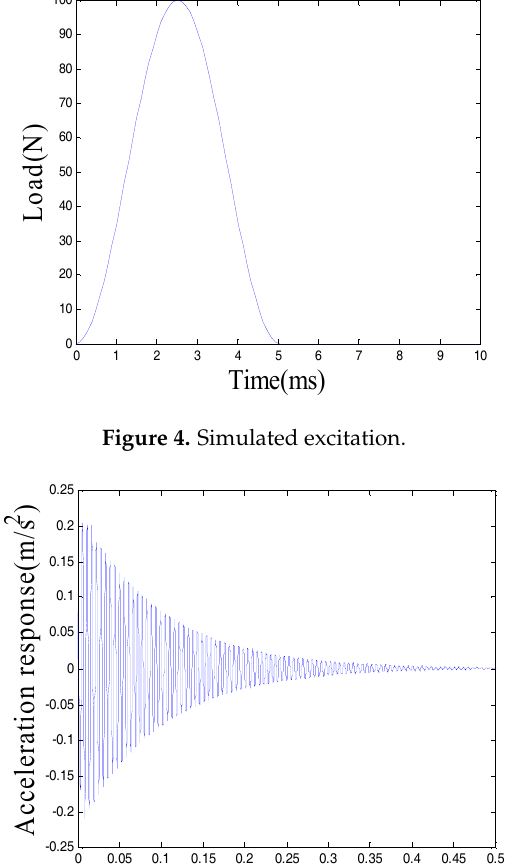
Figure 5. Acceleration response.